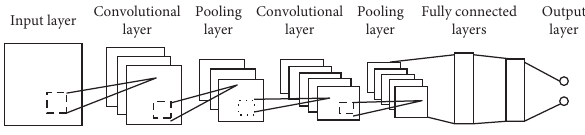
Figure 6: Architecture of